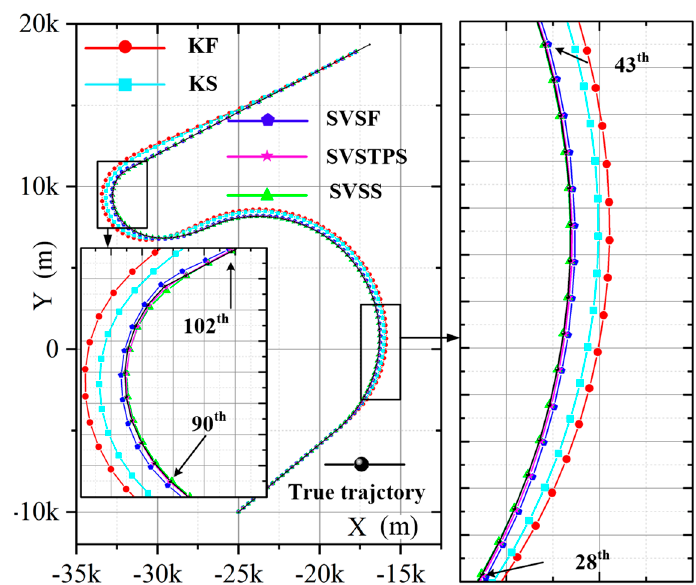
Figure 8. Average position trajectory. Sensors 2020 , 20 , x FOR PEER REVIEW Figure 9. Average position trajectory. Table 3. The state estimation accumulative RMSE on x-axis and y-axis (m) for different algorithms.